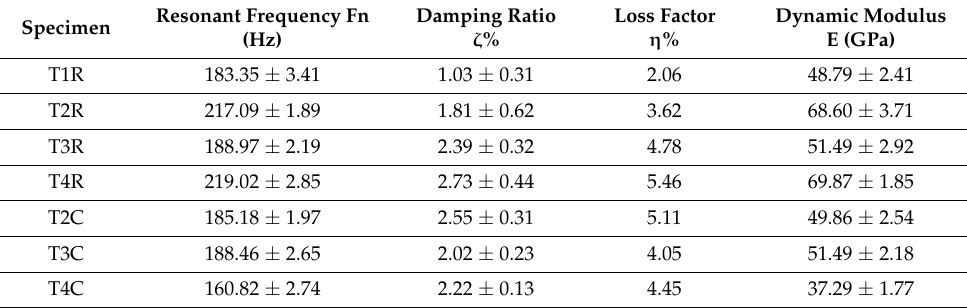
Table 3. The dynamic properties of the tested specimens.